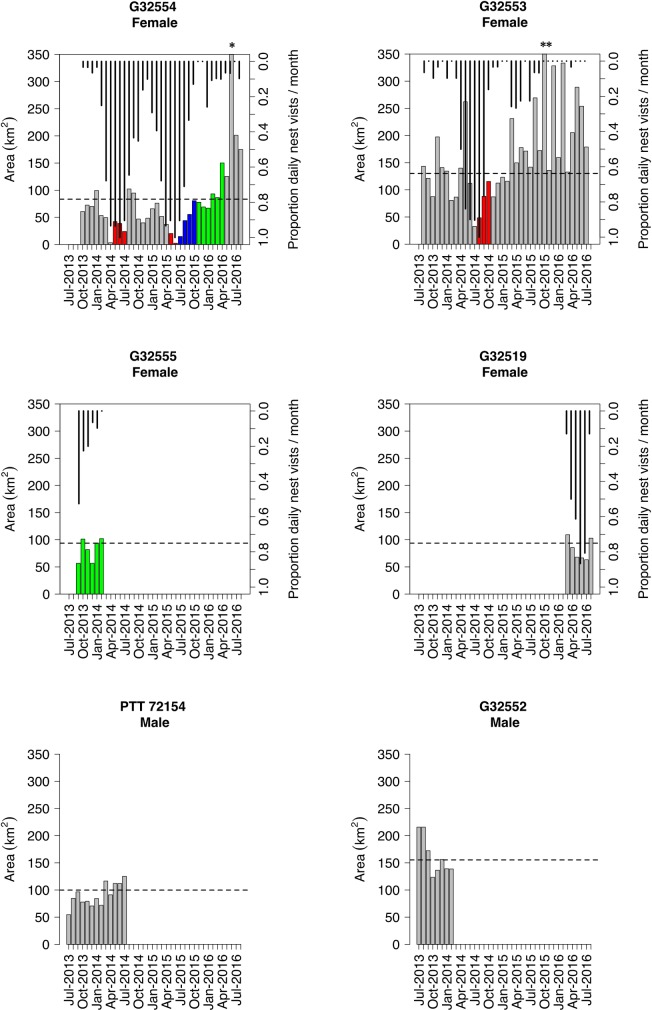
The 95% kernel density estimate (KDE) home range sizes for each individual by month.Missing bars indicate no data due to cessation of tag transmission. Coloured bars indicate months in which the individual bird was recorded to incubate (red), raise a fledgling (blue) or provision a fledged chick in post fledging dependency (green). Horizontal dashed lines indicate the 95% KDE for the entire dataset of each individual. Vertical lines indicate the proportion of days per month that a nest site was visited by the individual. * 1493 km2; ** 2319 km2